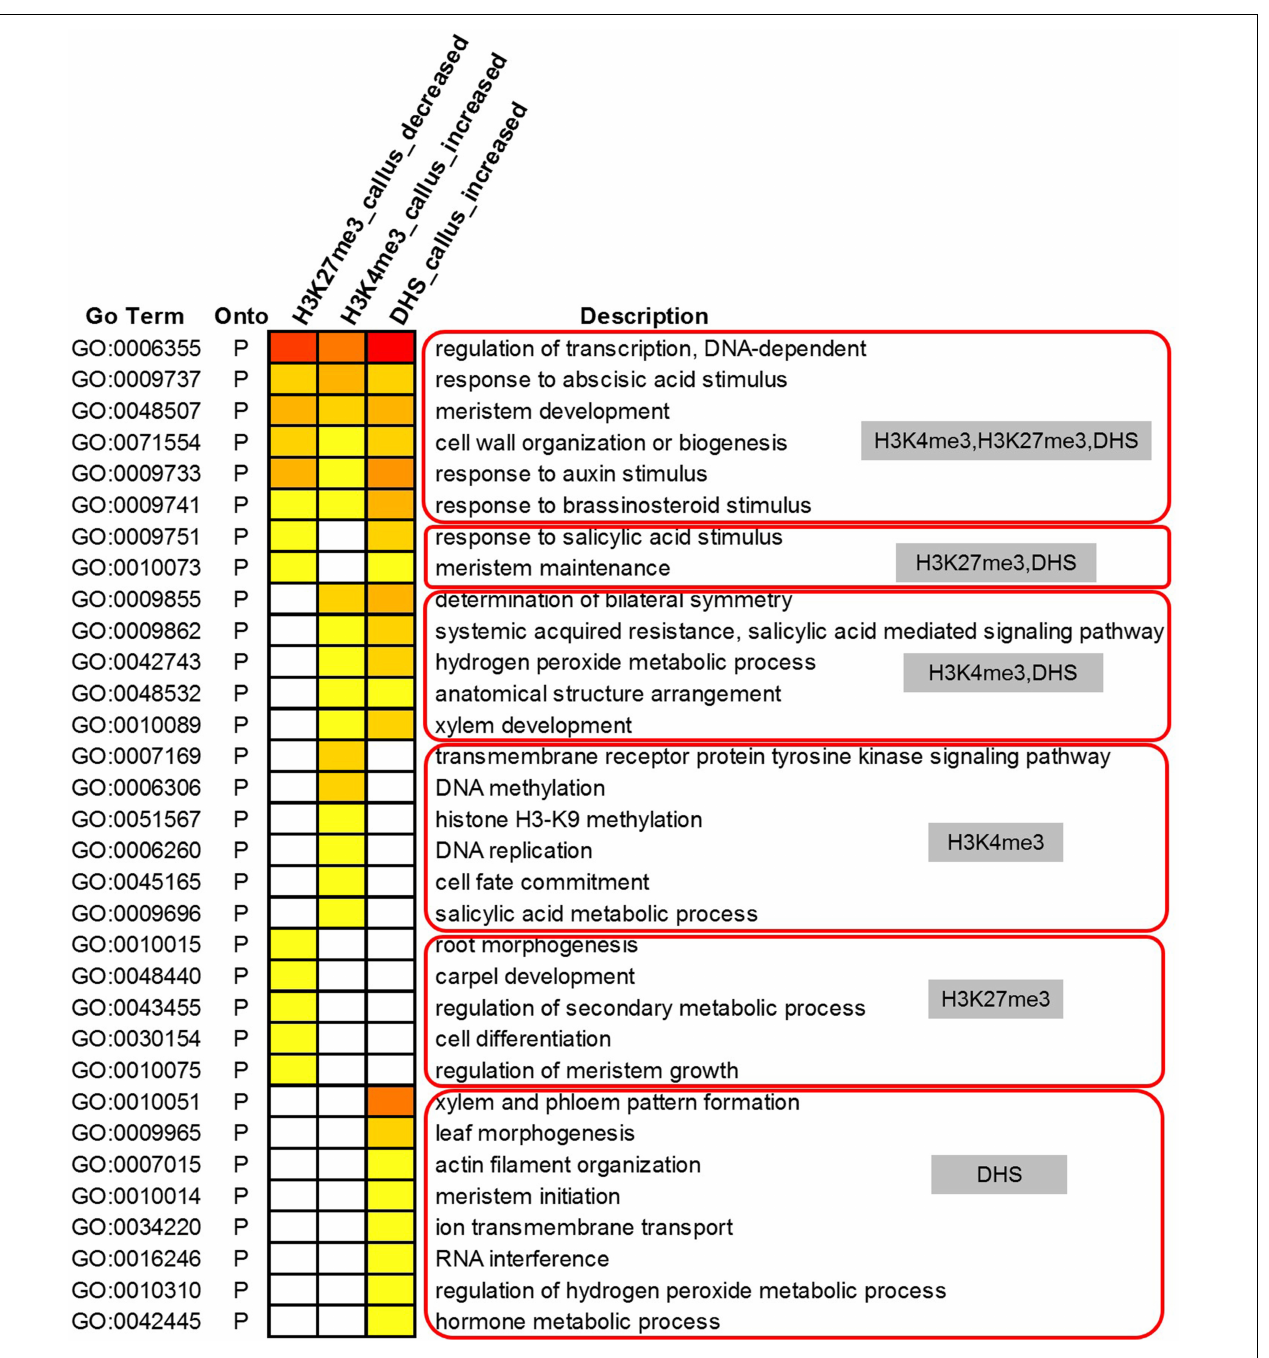
FIGURE 6 | Gene Ontology analysis of 1,565 highly expressed genes with lower deposition of H3K27me3 but higher deposition of H3K4me3 and DHSs in the callus.